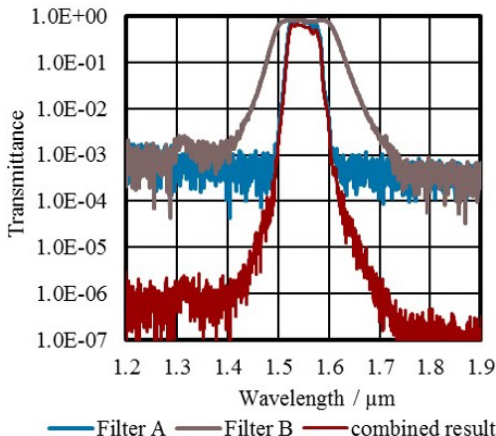
Figure 2. Transmittances of two filters with bandpass regions at 1.55µm measured with a Fourier transform spectrometer (blue and brown) and the calculated resulting transmission of both filters com- bined (red) with significantly improved out-of-bandpass